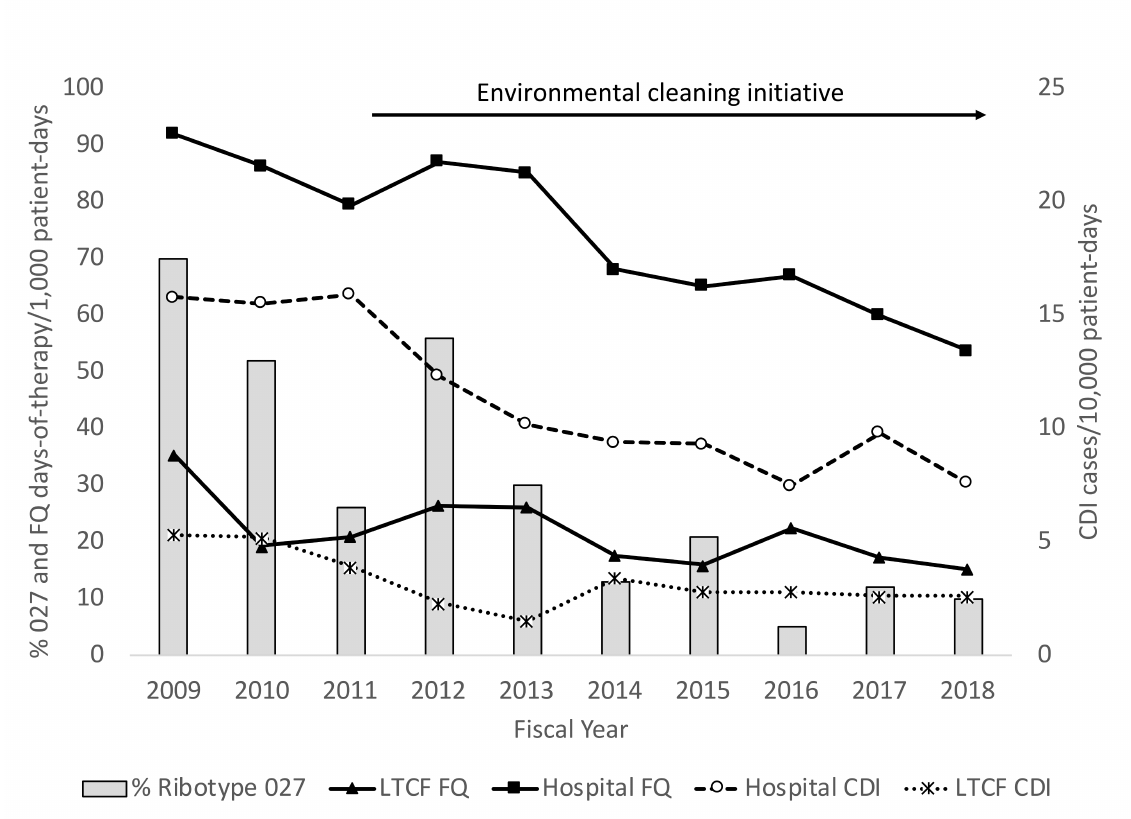
Figure 1 . Changes in the incidence of hospital- and long-term care facility (LTCF)-associated Clostridi- oides difficile infection (CDI) and in the percentage of CDI infections due to ribotype 027 strains during a period of decreasing fluoroquinolone use. The environmental cleaning initiative resulted in reduced environmental contamination with C. difficile . Stewardship interventions also resulted in reductions in hospital use of penicillins, carbapenems, and intravenous vancomycin during the study period. Note. FQ,